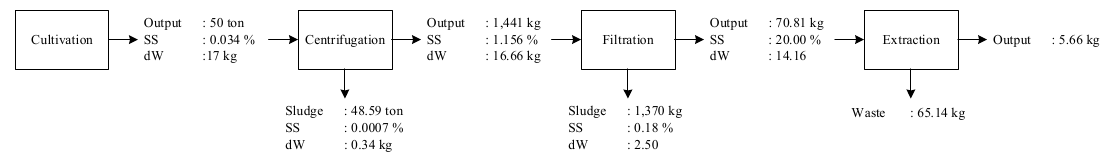
Figure 5. Mass balance of microalgae oil production at the Minamisoma pilot plant.